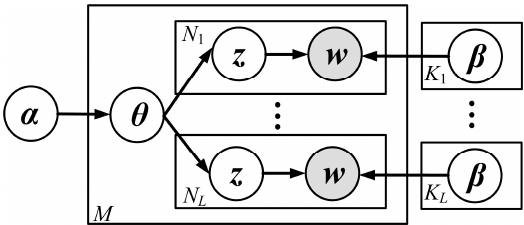
Figure 5. Graphical representation of the proposed AI-MFLDA method.